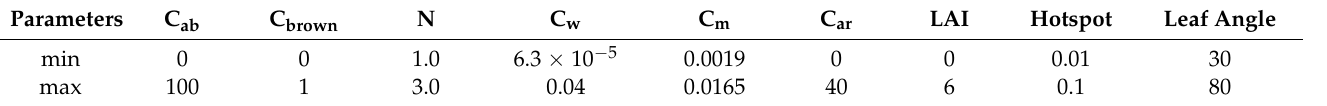
Table 3. The range of input parameters in PROSPECT + 4SAIL